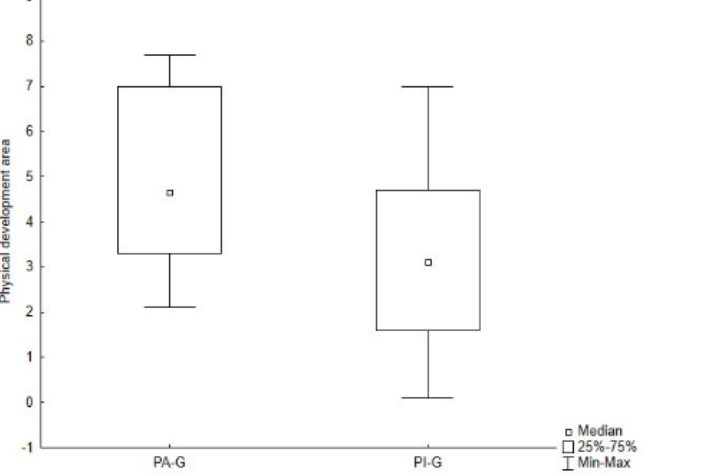
Figure 6. Difference in aiming and catching skills of the M-ABC between groups. Legend. PA-G, Physically Active Group; PI-G, Physically Inactive Group.